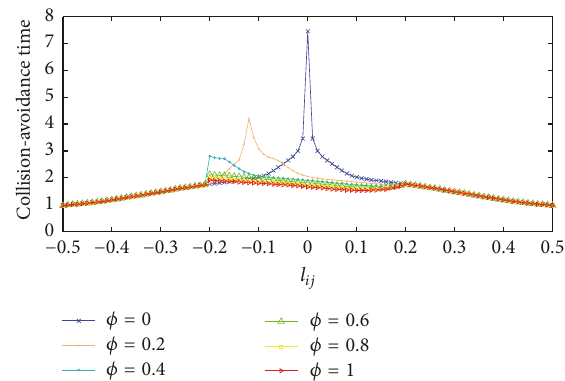
Figure 9: The collision-avoidance time versus the relative position 𝑙 𝜙 (strength parameter of the f 𝑖𝑗 for different